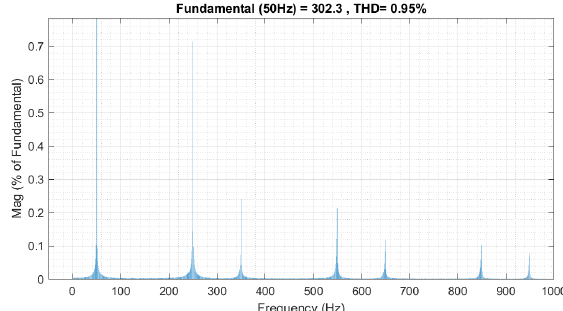
Figure 15. Transformer secondary/rectifier input voltage total harmonic distortion for three EV fast chargers.